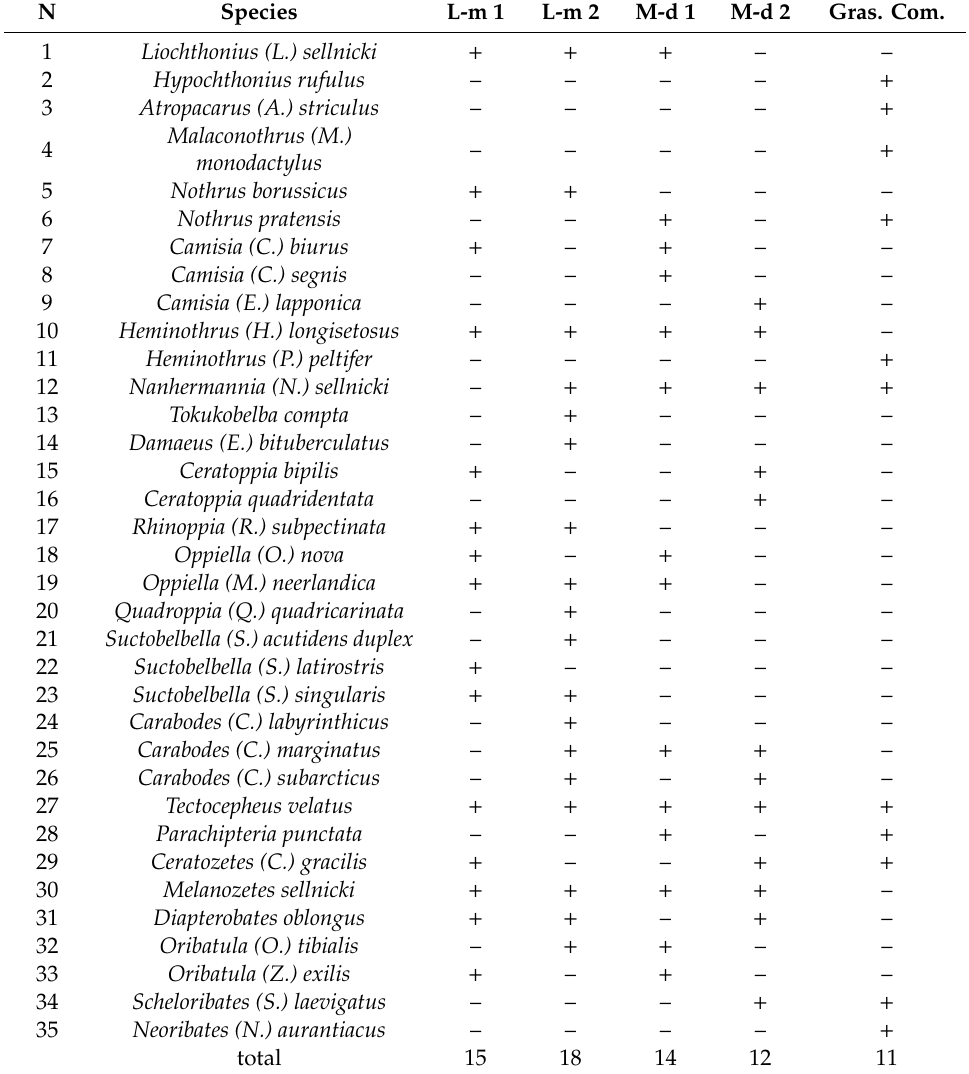
Table 2. The species composition of oribatid mites in the plant communities of the Subpolar